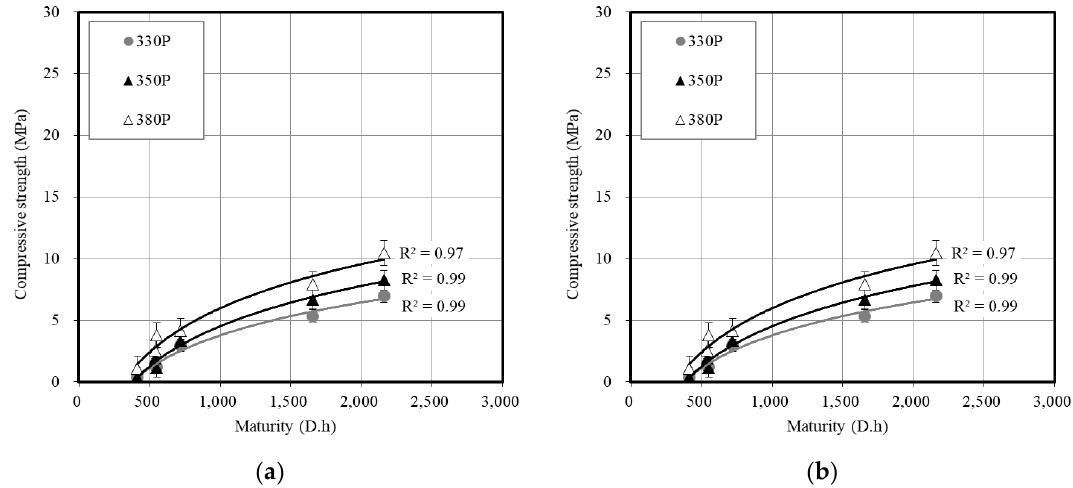
Figure 4. Relation between maturity and concrete strength at early ages: ( a ) Cement amount and ( b ) cement type and chemical admixture.